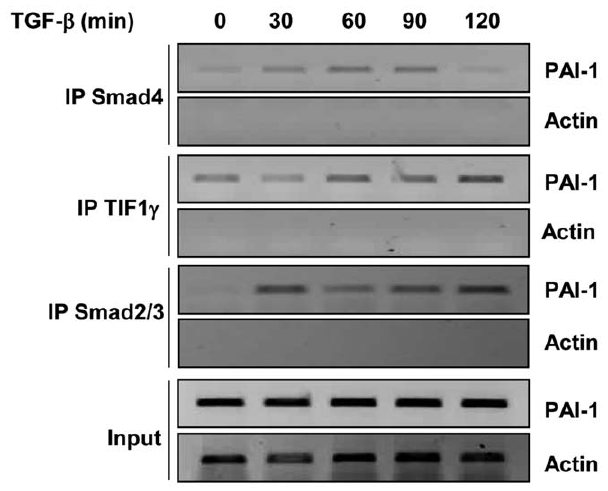
Figure 4. TIF1 c , Smad2 and Smad4 bind to the PAI-1 promoter. ChIP assays were performed on HMEC cells treated with TGF- b for the indicated times. Cell lysates were subjected to anti-Smad4 (IP Smad4), or anti-TIF1 c (IP TIF1 c ), or anti-Smad2/3 (IP Smad2/3) chromatin immunoprecipitation. PCR amplification of the endogenous PAI-1 promoter (733/484) was performed to detect protein bound DNA. Primers specific to actin were used as controls.